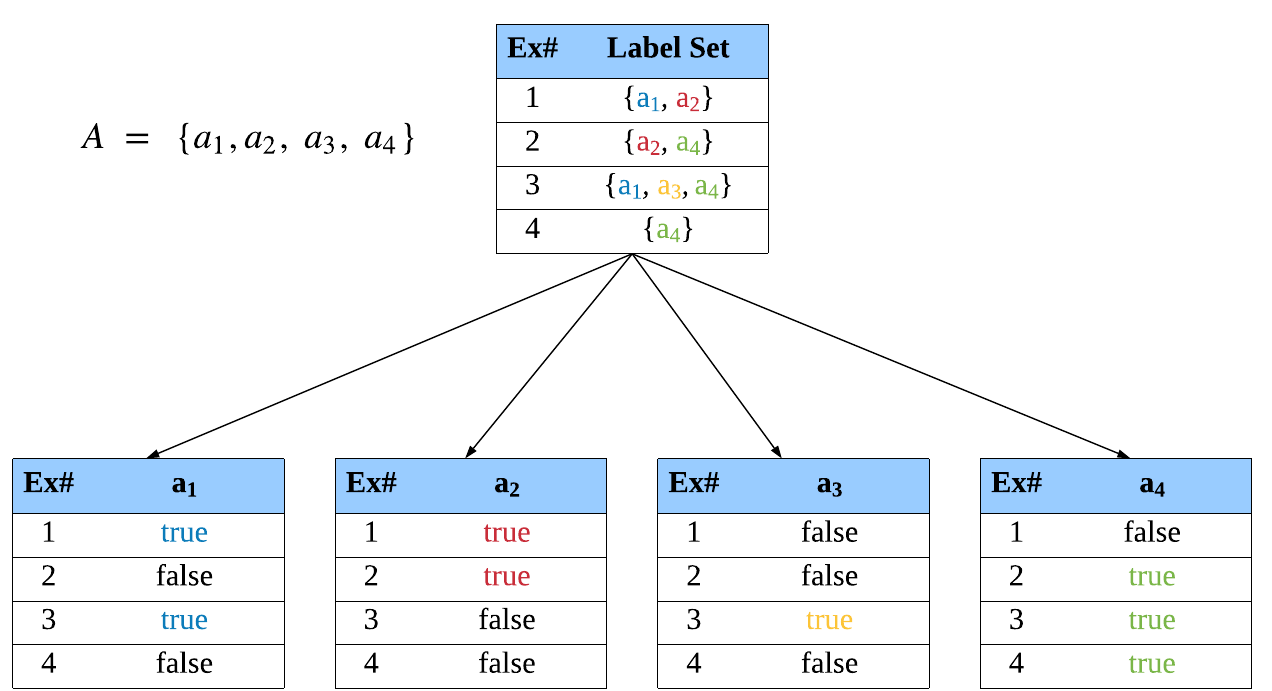
Figure 4. Illustration of the decomposition of a multi-label data set into multiple binary data